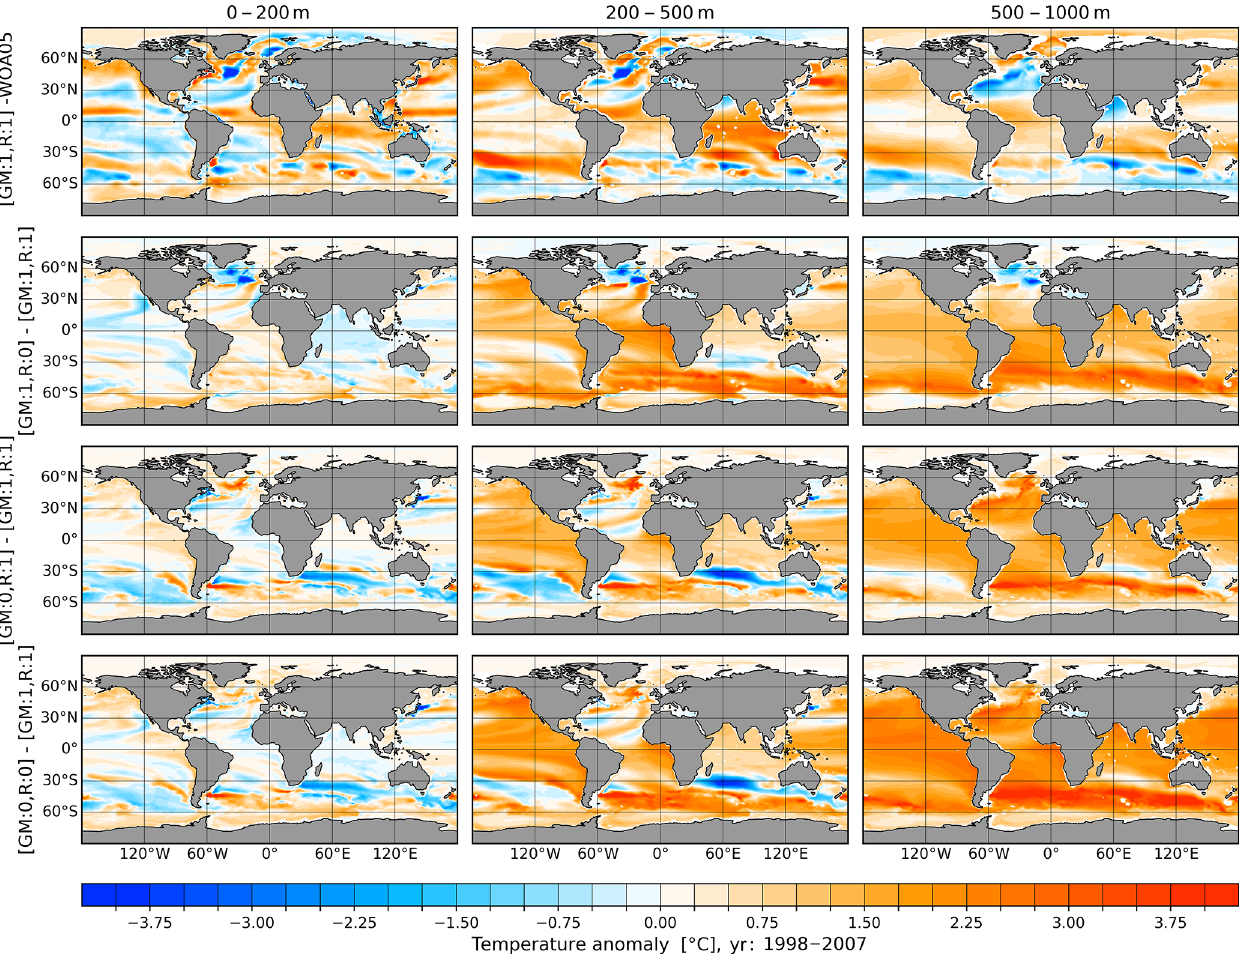
Figure 6. First row: temperature biases in the reference simulation with respect to the World Ocean Atlas 2005 (WOA05; Locarnini et al., 2006; Antonov et al., 2006) climatology for three different depth ranges: 0–200m (left), 200–500m (middle) and 500–1000m (right). In the reference simulation, both the GM and Redi diffusion parameterizations are switched on (:1). Another three rows show the temperature differences between sensitivity runs and the reference run. The second row shows the impact when only the Redi diffusivity is switched off (:0), the third row when only GM is switched off and the fourth row when both of them are switched off. The average over the period of 1998–2007 is